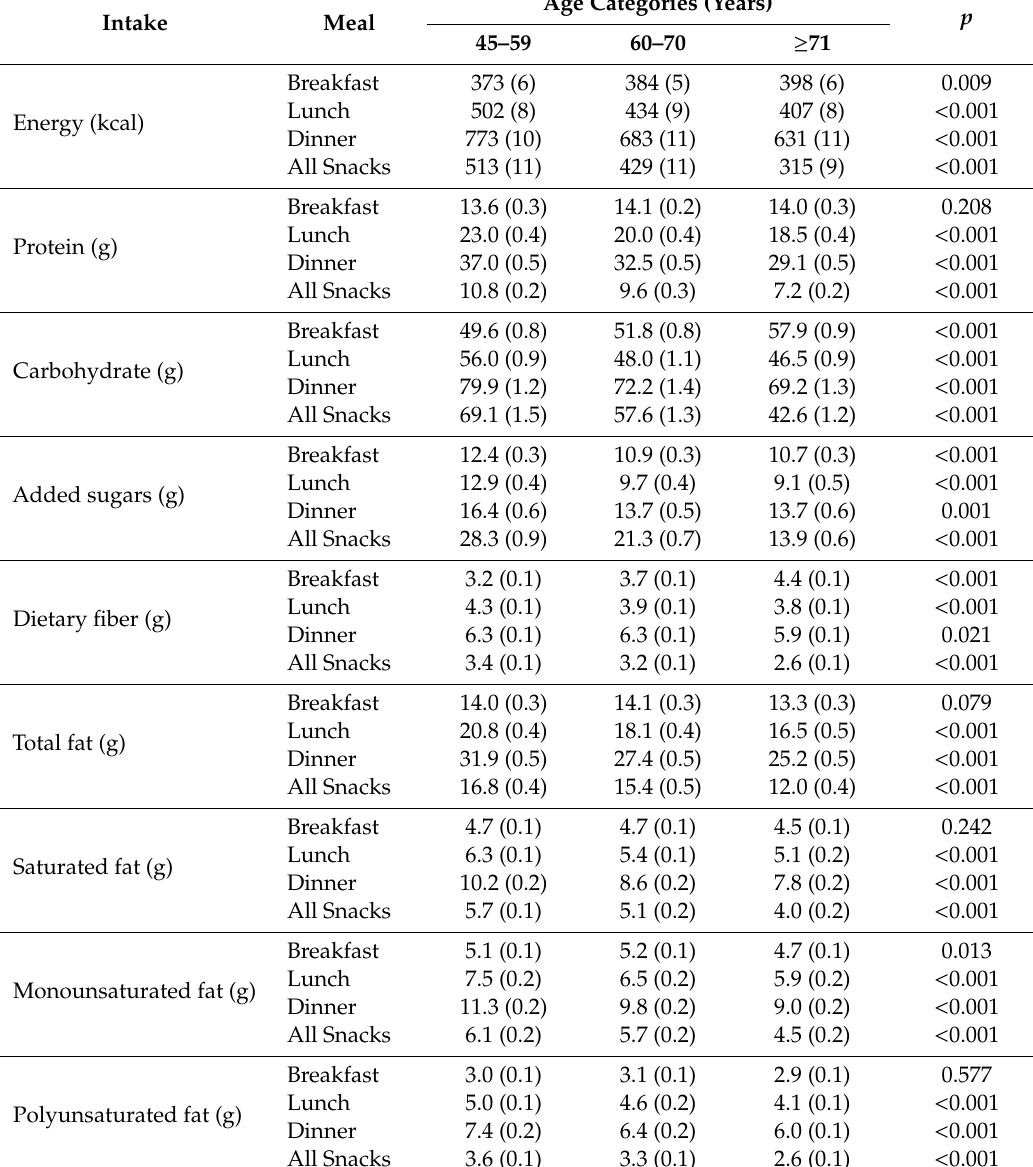
Table 2. Di ff erences in mean intakes of macronutrients obtained at meals and snacks by age